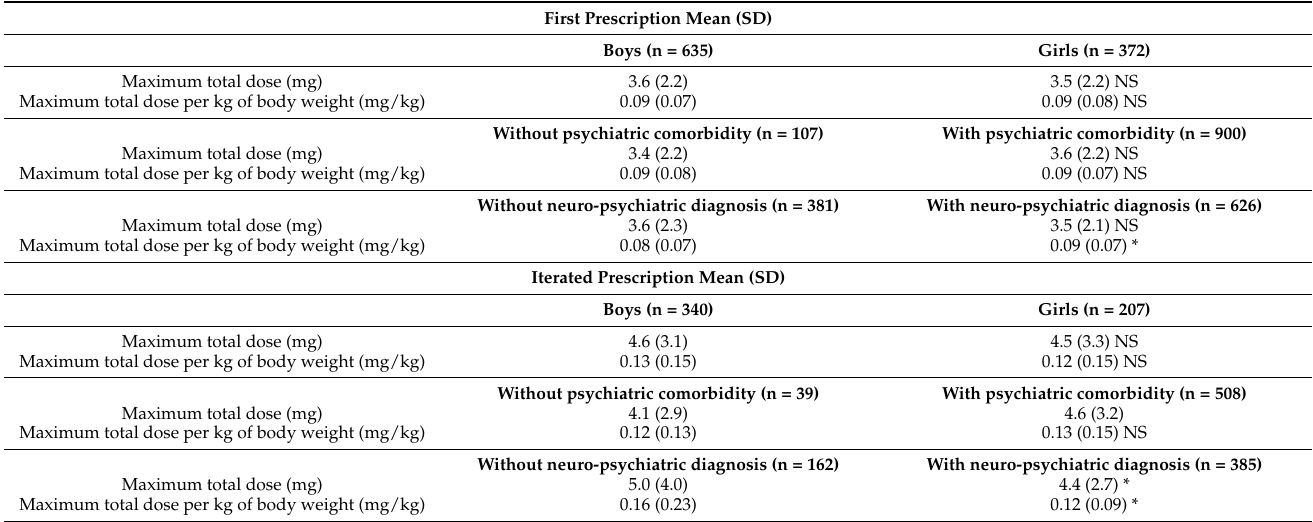
Table 3. Maximum prescribed melatonin total dose and dose per kg of body weight in relation to sex, psychiatric, and neuro-psychiatric co-morbidities. First Prescription Mean